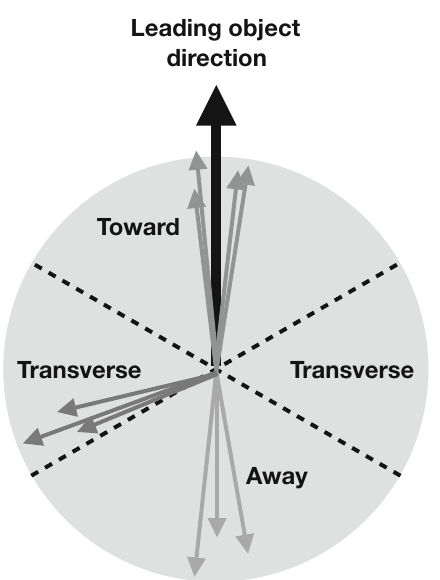
Fig. 1 Illustration of several φ regions relative to the leading object that are sensitive to the underlying event. See the text for the details on the definitions of the regions